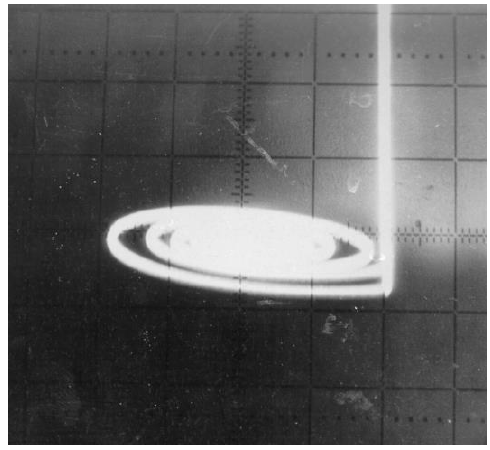
Fig. 6. Photograph of the phase portrait in the system in the PLL with the additional process